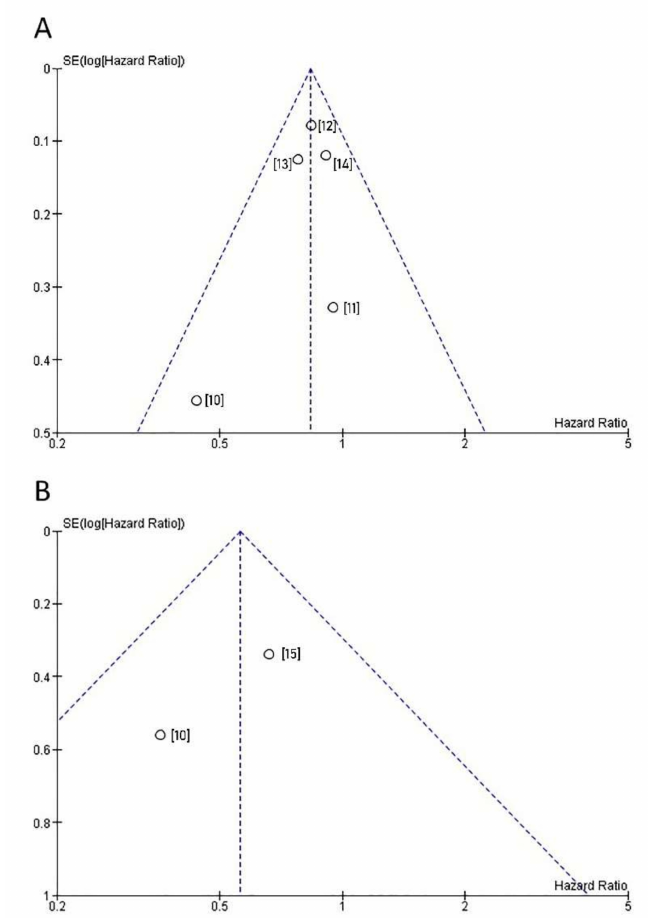
Figure 3. Funnel plot for evaluation of publication bias for ( A ) overall survival, and ( B ) disease- specific survival. Circles represent hazard ratios (x axis) and standard errors (y axis) of particular studies (references are placed in square brackets).